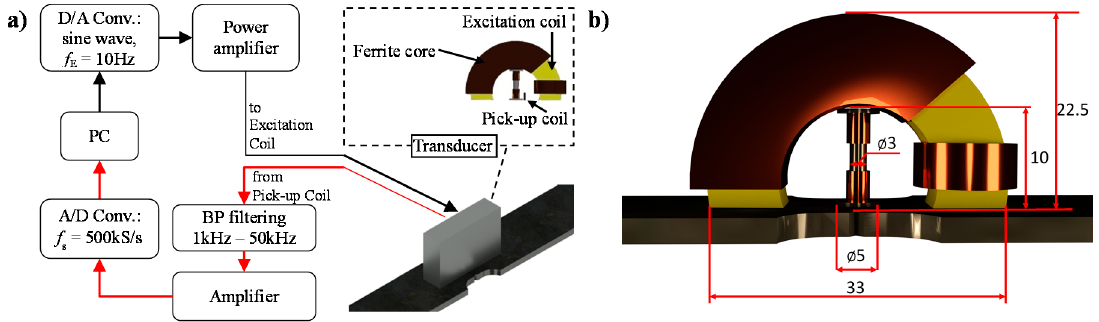
Figure 2. Measuring system setup: ( a ) the block diagram, ( b ) view with dimension of transducer.